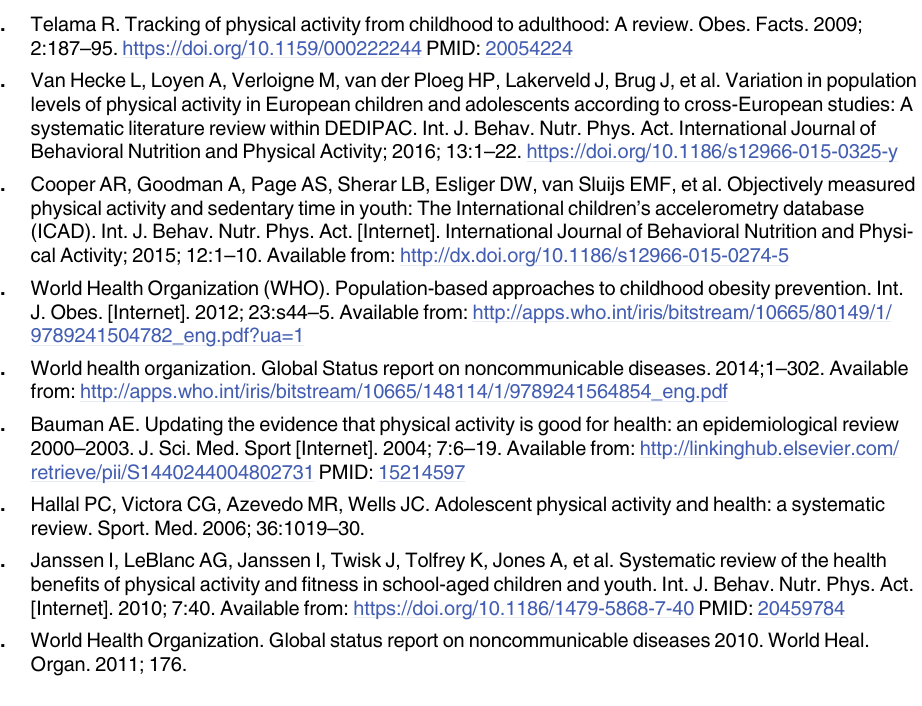
S2 Table. Relative importances of each park characteristic for park-based PA, socio-demo- graphics, PA behavior and park use characteristics for the three subgroups identified by latent class analysis (complete table). a significant difference with subgroup 1; b significant difference with subgroup 2; c significant difference with subgroup 3; � p <